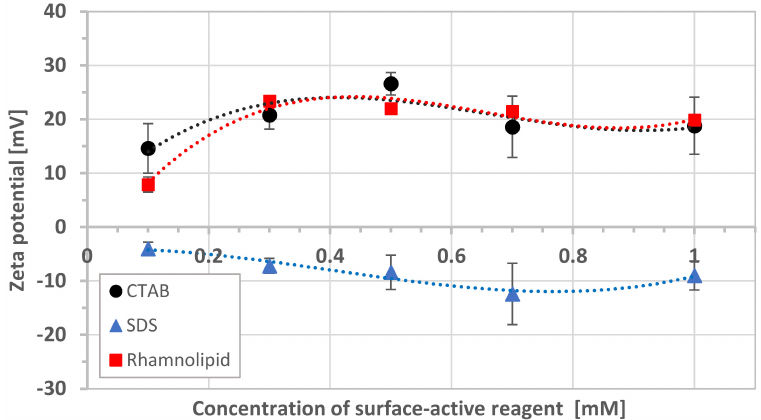
Figure 4. The e ff ect of synthetic surfactants and rhamnolipid on the zeta potential of bacteria (ionic strength 10 − 3 M NaCl, pH 3).